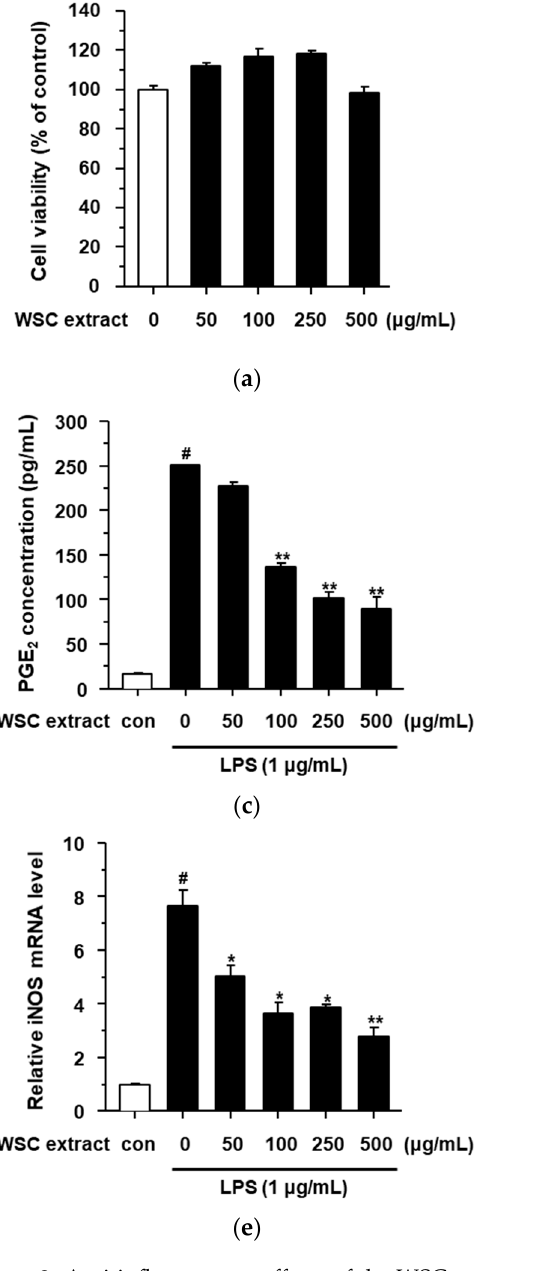
Figure 3. Anti-inflammatory effects of the WSC extract on LPS-stimulated RAW264.7 cells: ( a ) Cytotoxicity of the WSC extract was measured via dimethylthiazol-diphenyltetrazolium bromide assay; ( b ) Griess reaction assay was performed to determine NO production; ( c ) PGE 2 concentration was determined using an ELISA kit; ( d , e ) iNOS and COX-2 mRNA levels were analyzed by quantitative real-time PCR; ( f ) iNOS and COX-2 protein levels were determined by western blotting assay. Values are expressed as the mean ± standard deviation of three independent experiments; #, p < 0.005 versus control; *, p < 0.05; **, p < 0.005 versus LPS alone.